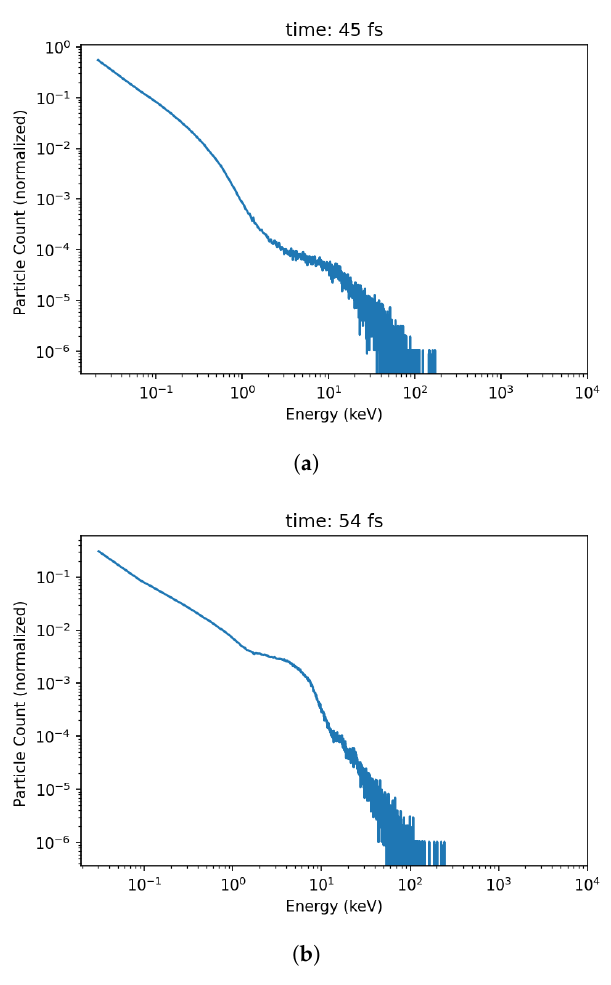
Figure 9. Example electron energy distributions at two times: after the first laser leaves simulation domain ( a ) and when the second laser reaches half way through the simulation domain ( b